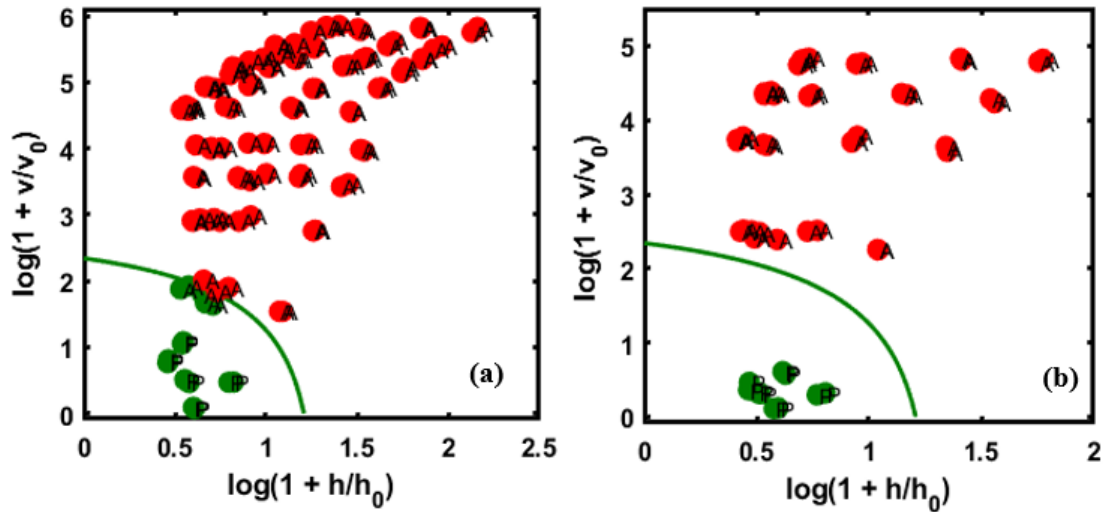
Figure 7. DD-SIMCA results for almond samples adulterated with apricot. Validation set-1 ( a ), and validation set-2 ( b ). The validation sets consisted of data from two different varieties of almond powder.